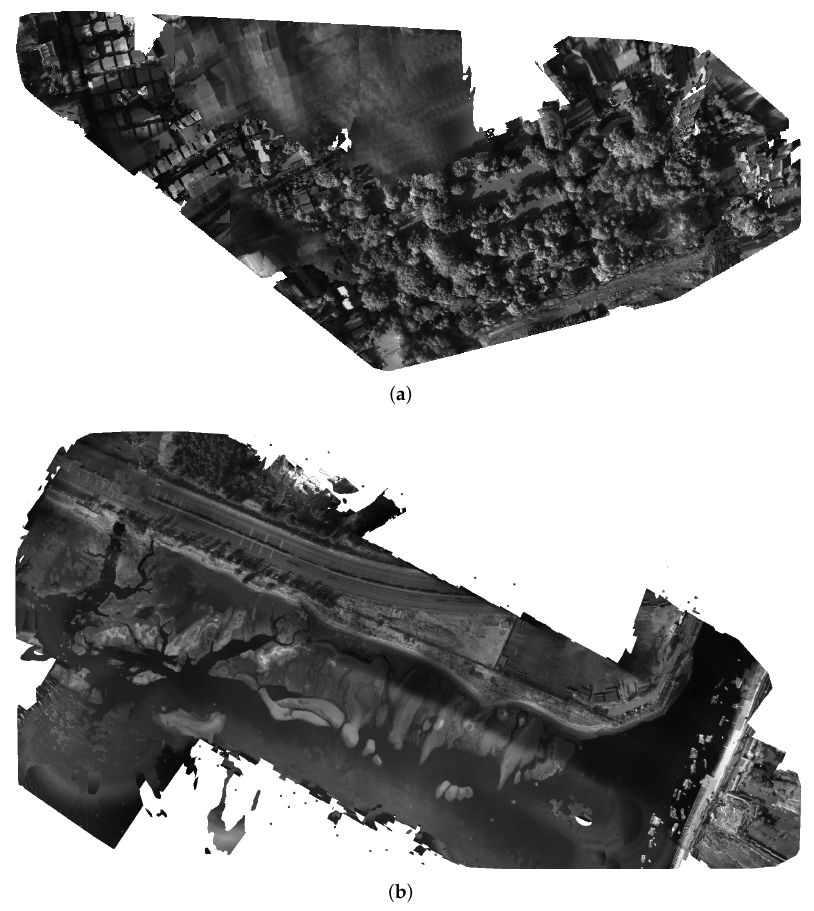
Figure 9. The results of aerial remote-sensing map construction at 300 meters high. ( a ) The blurred aerial SWIR image map. ( b ) The high-quality aerial SWIR image map via our proposed LMFM